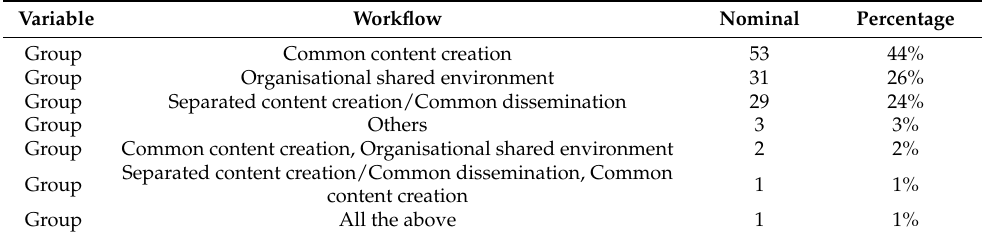
Table 16. Workflow.